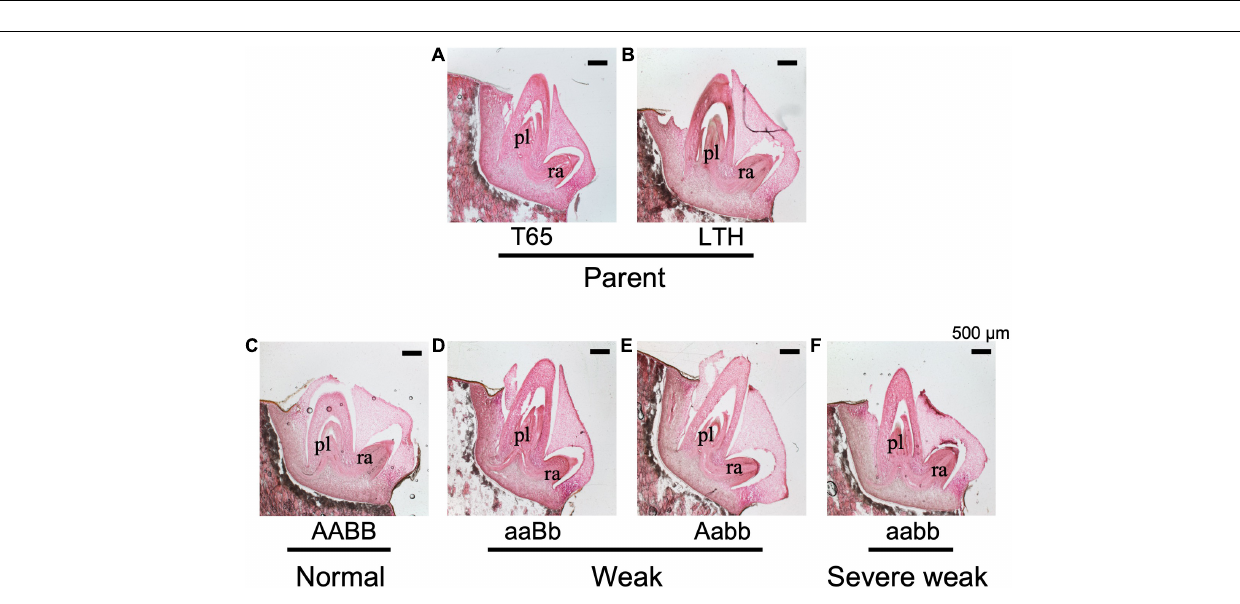
FIGURE 10 | Histological characteristics of embryos of F 2 and the parents in germinating seeds 1 day after soaking in water at 24 ◦ C. (A) T65, (B) LTH, (C) normal genotype, (D,E) weak genotypes, and (F) severe weak genotype. The sections (20 µ m thick) were stained with hematoxylin and eosin. pl, plumule (shoot meristem); ra, radicle. Scale bars = 500 µ